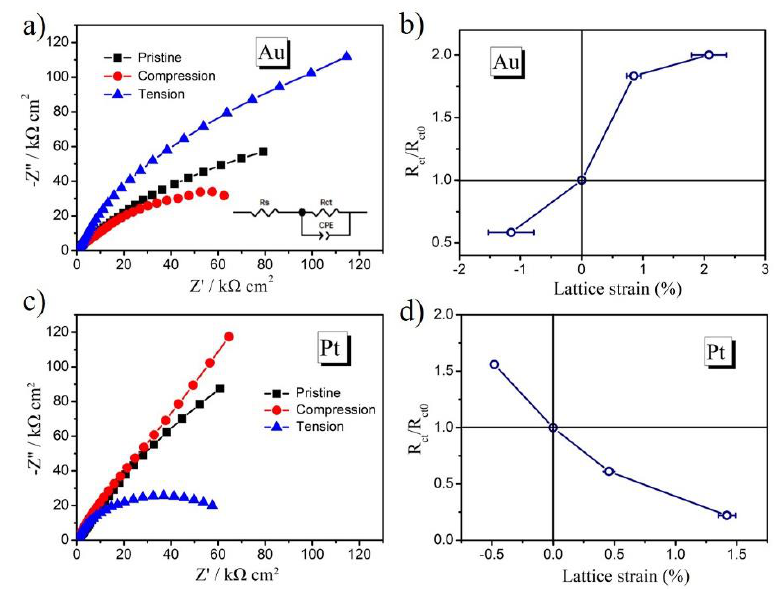
Figure 5. a) Electrochemical impedance spectroscopy (EIS) spectra of the Au film. b ) The relationship Figure 5. ( a) Electrochemical impedance spectroscopy (EIS) spectra of the Au film; ( b ) The relationship of lattice strain and the R ct variation of Au film. c ) EIS spectra of the Pt film. d ) The relationship of of lattice strain and the R ct variation of Au film; ( c ) EIS spectra of the Pt film; ( d ) The relationship of lattice strain and the R ct variation of Pt film. lattice strain and the R ct variation of Pt